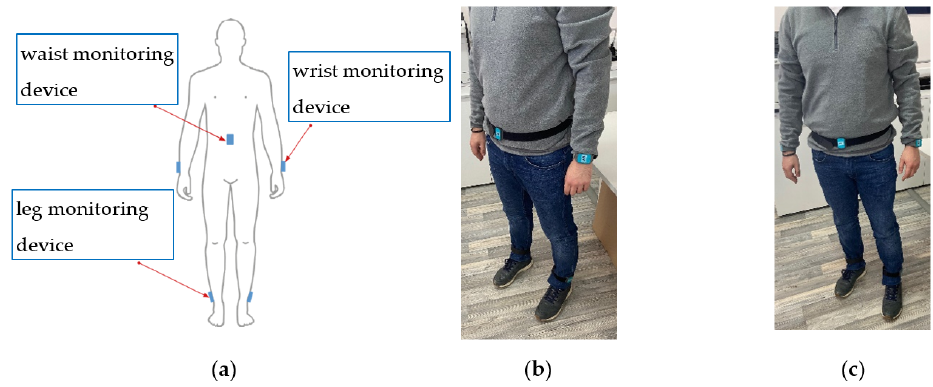
Figure 2. PDMonitor ® worn on the body: ( a ) schematic; ( b ) side view; ( c ) front view. The axes of the MDs are aligned during post-processing to a global frame (Figure 3). The x-axis is the one defined as containing the gravity component. The accessories help wear the MDs facing outwards (dorsal side) so the z -axis is always positive in a distal orientation regarding the wearer’s body. This is also an instruction included in the instruc- tions for use of the device. Wearing the MDs facing towards the body, either regarding the wrists or the shanks, is possible, but strictly advised against, as this would confuse the algorithm.